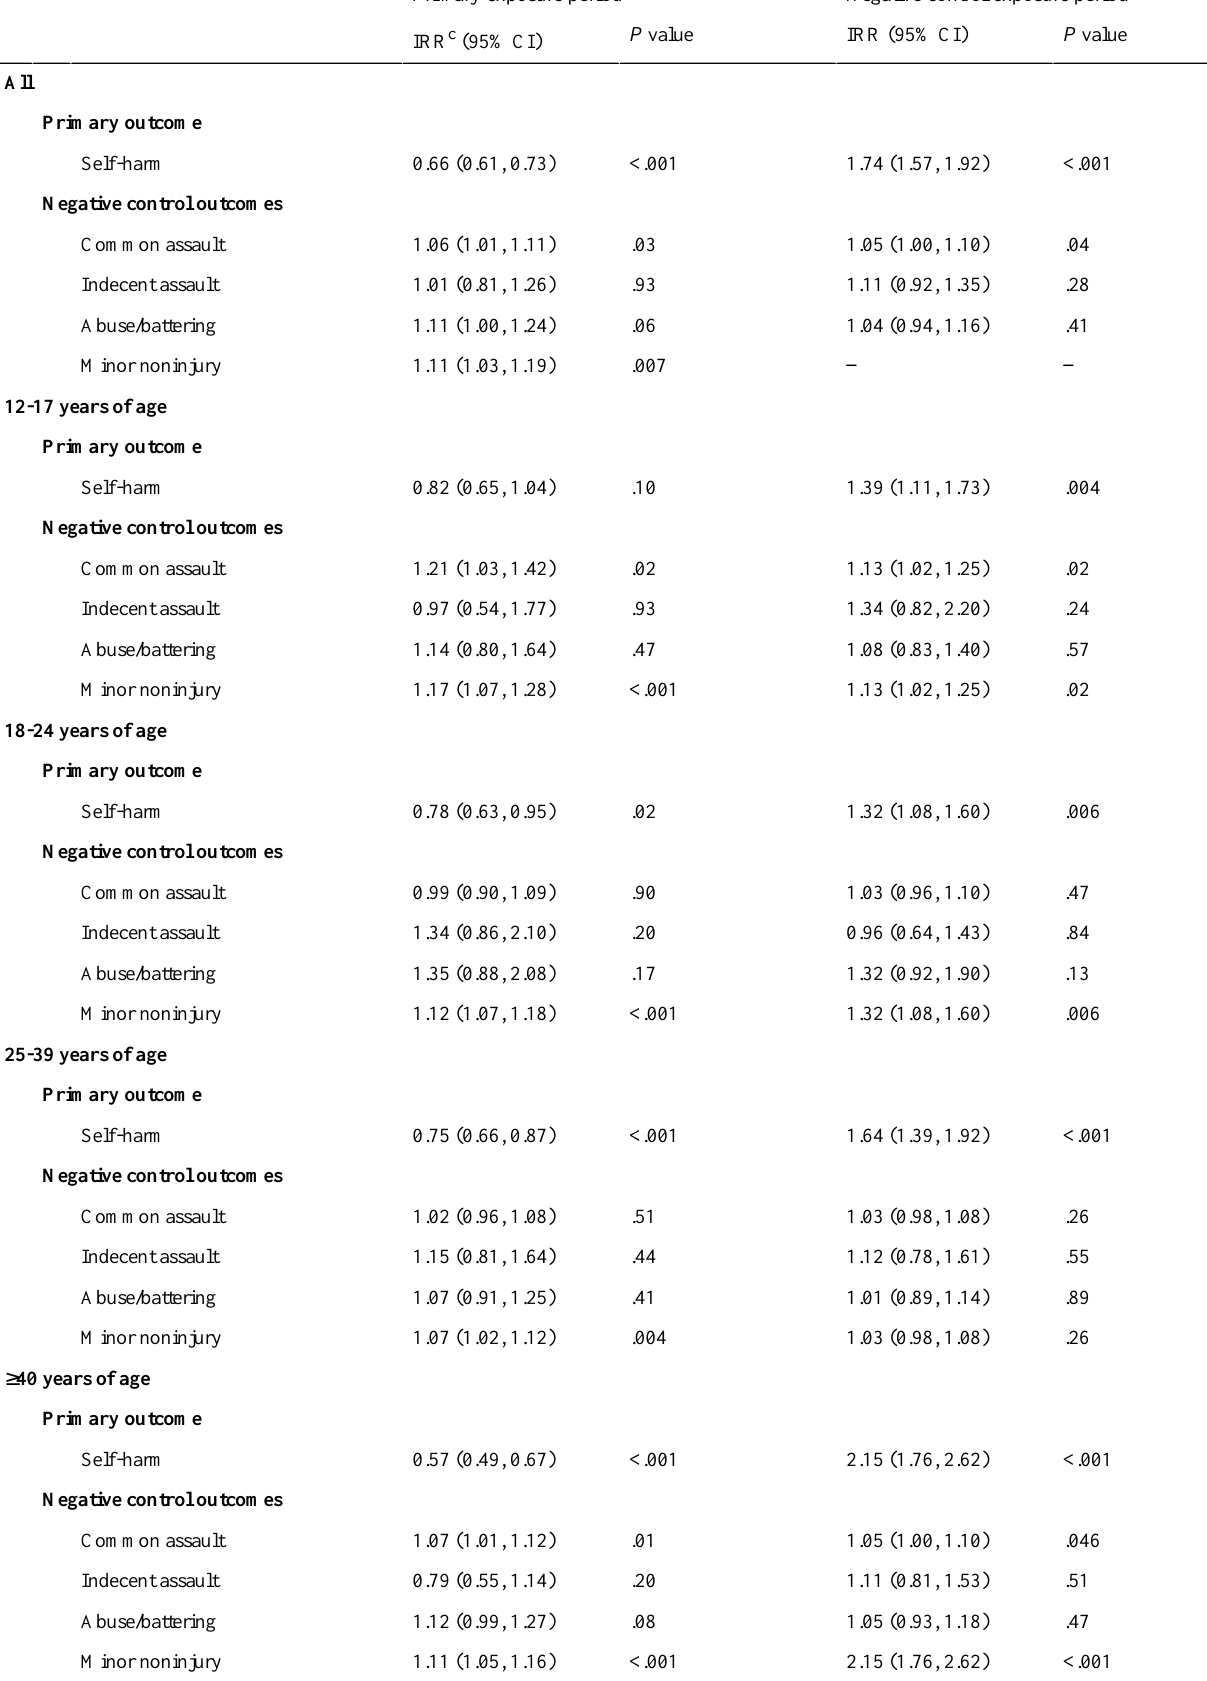
Table 2. Association between Pokémon Go and accident and emergency attendance from robust Poisson regression with adjustments for time trends, seasonal trends, age, gender, and population